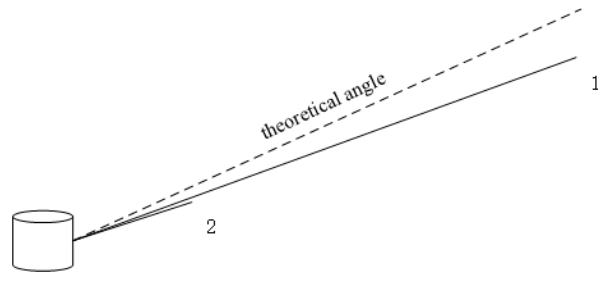
Figure 10. Impact of angle and laser path length on the degree of dispersion.